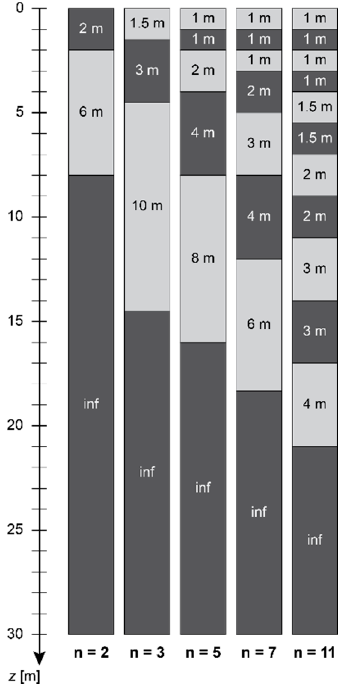
Figure 8. Initial layer thicknesses assumed for inversion of the synthetic dispersion curves from models B and C.